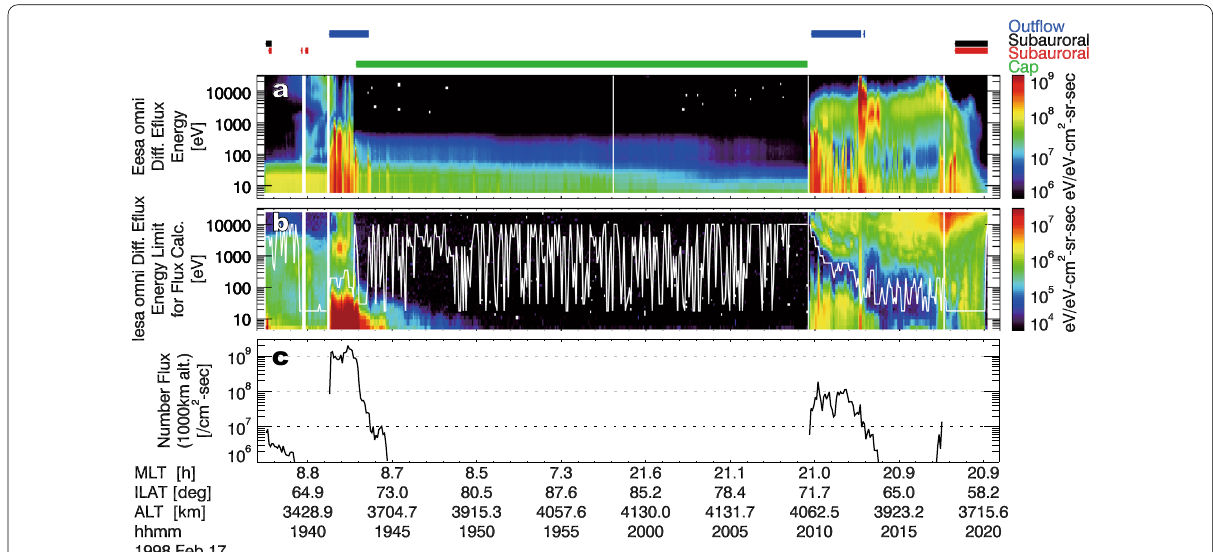
Fig. 1 Example of observations at high latitudes. Omnidirectional energy–time spectrograms of differential energy flux of a electrons and b ions, and c number fluxes of ions observed by IESA. Blue and green bars indicate the periods of the outflow regions (“Dataset and selection of ion outflow events” section) and the polar cap (Appendix A4), respectively. Black and red bars indicate the periods that are selected for the identification of the subauroral zone, and they are related to the high background count rates and double loss cones, respectively (Appendix A5). A white polygonal line in Fig. 1b is the upper energy limit for the calculation of number flux of